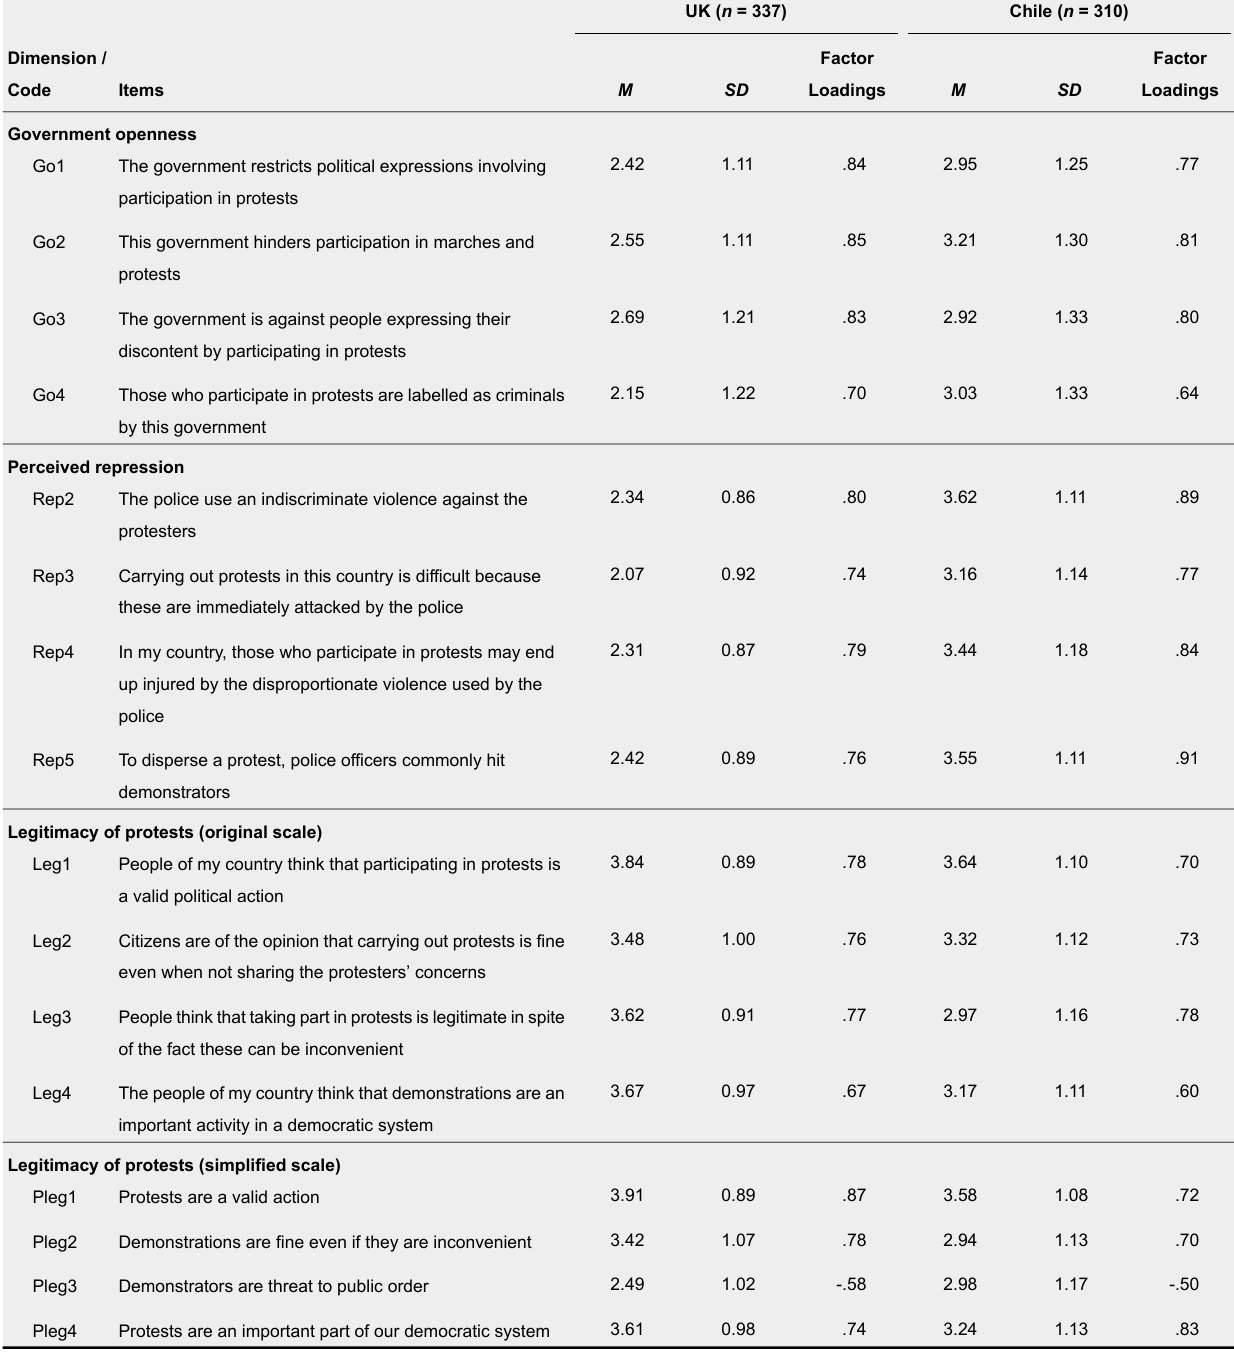
Chile ( n = 310)UK ( n =